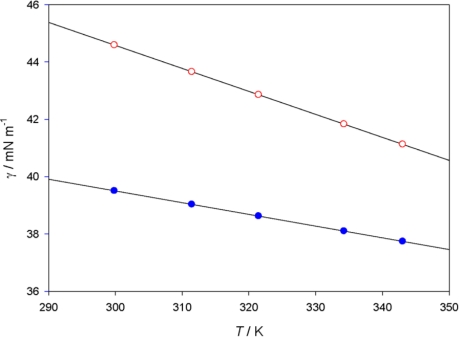
Plot of γ versus T of the [MPI][PF6] (
) and PEG400 (
).